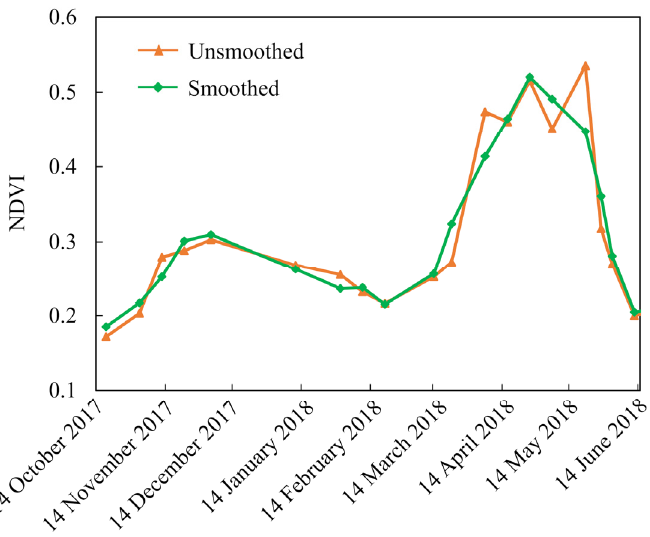
Figure 2. Normalized difference vegetation index (NDVI) time series of winter wheat before and after smoothing (Location: 37°50 ′ 29.73 ″ N, 116°15 ′ 12.75 ″ E).